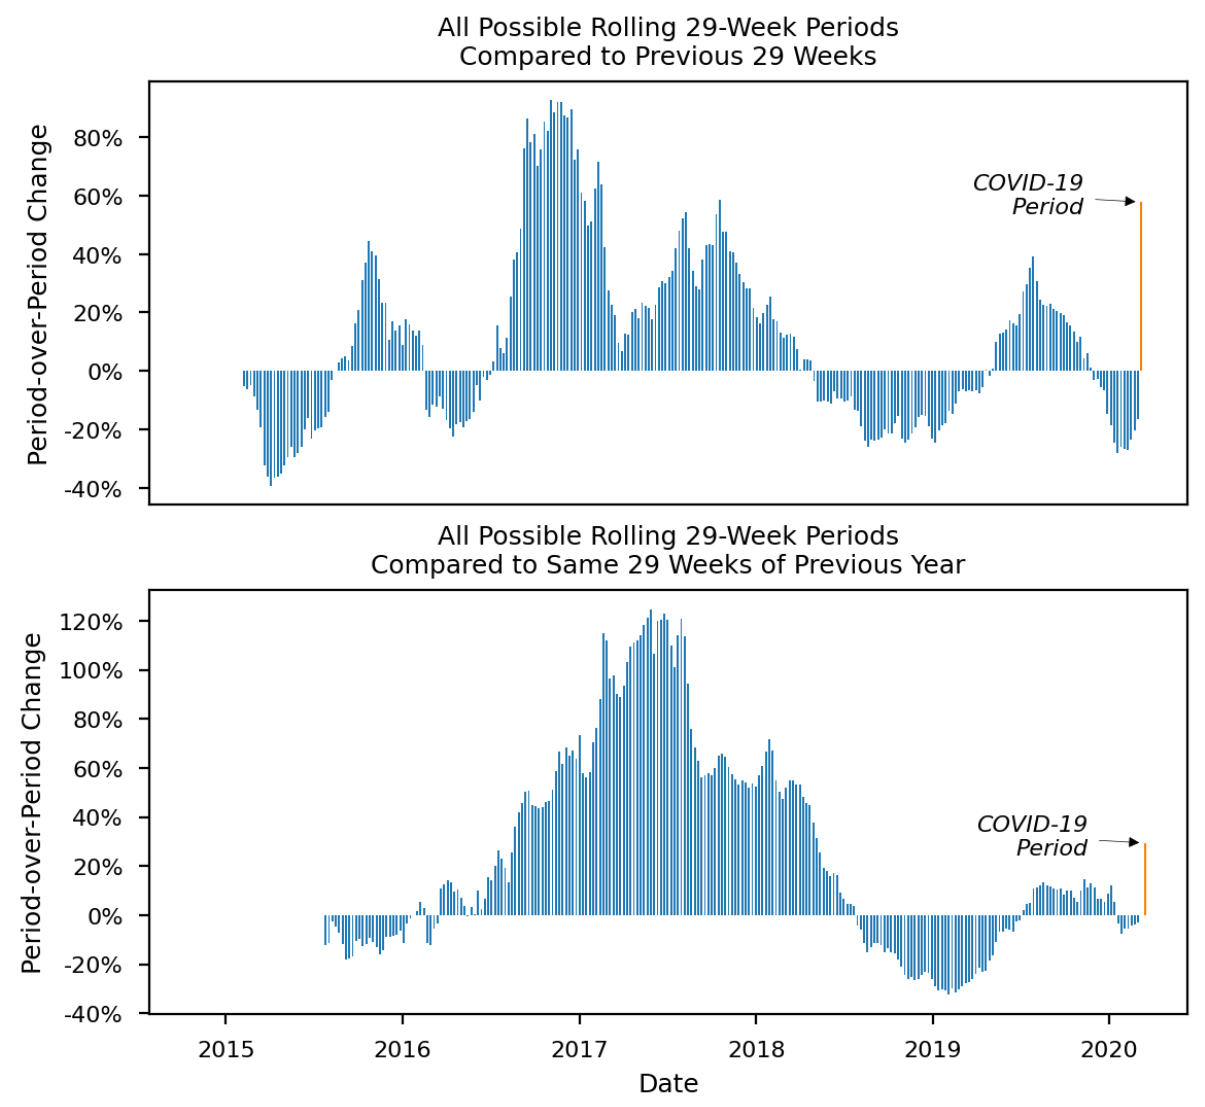
Figure 3. Historical period-over-period change in emergency medical services runs involving naloxone administrations in Guilford County, North Carolina before and after the COVID-19 state of emergency